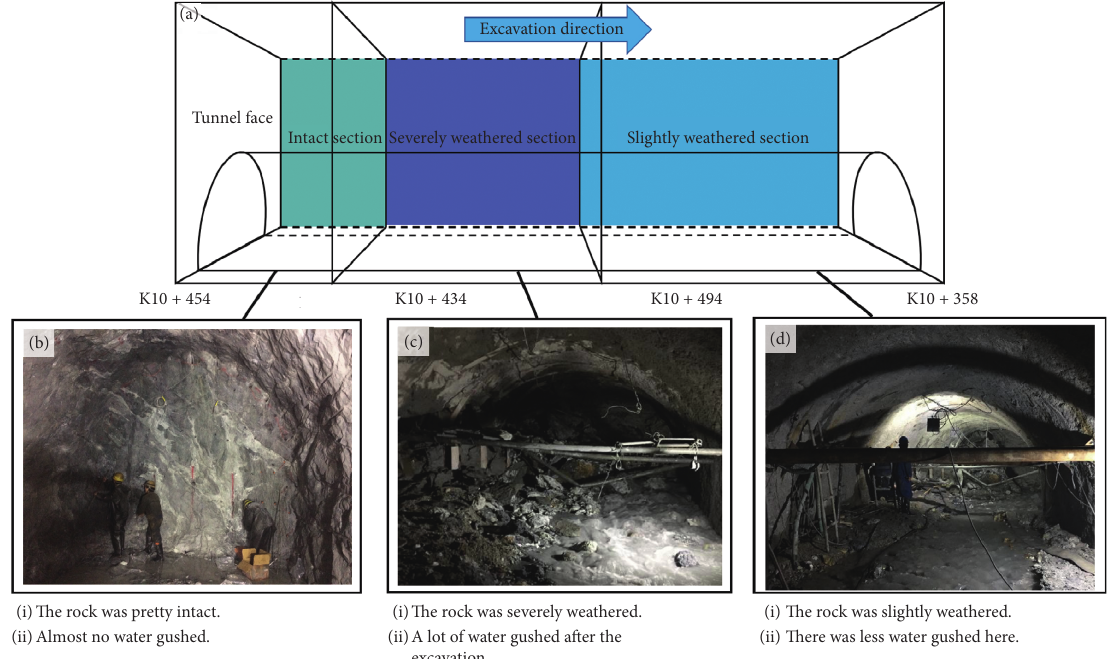
Figure 9: Comprehensive interpretations and excavation photos for each section. (a) Comprehensive map of rock masses within 100m of the front of the tunnel. (b) Excavation photo of the first section. (c) Excavation photo of the second section, with considerable water pouring. (d) Excavation photo of the third section, where water flow still